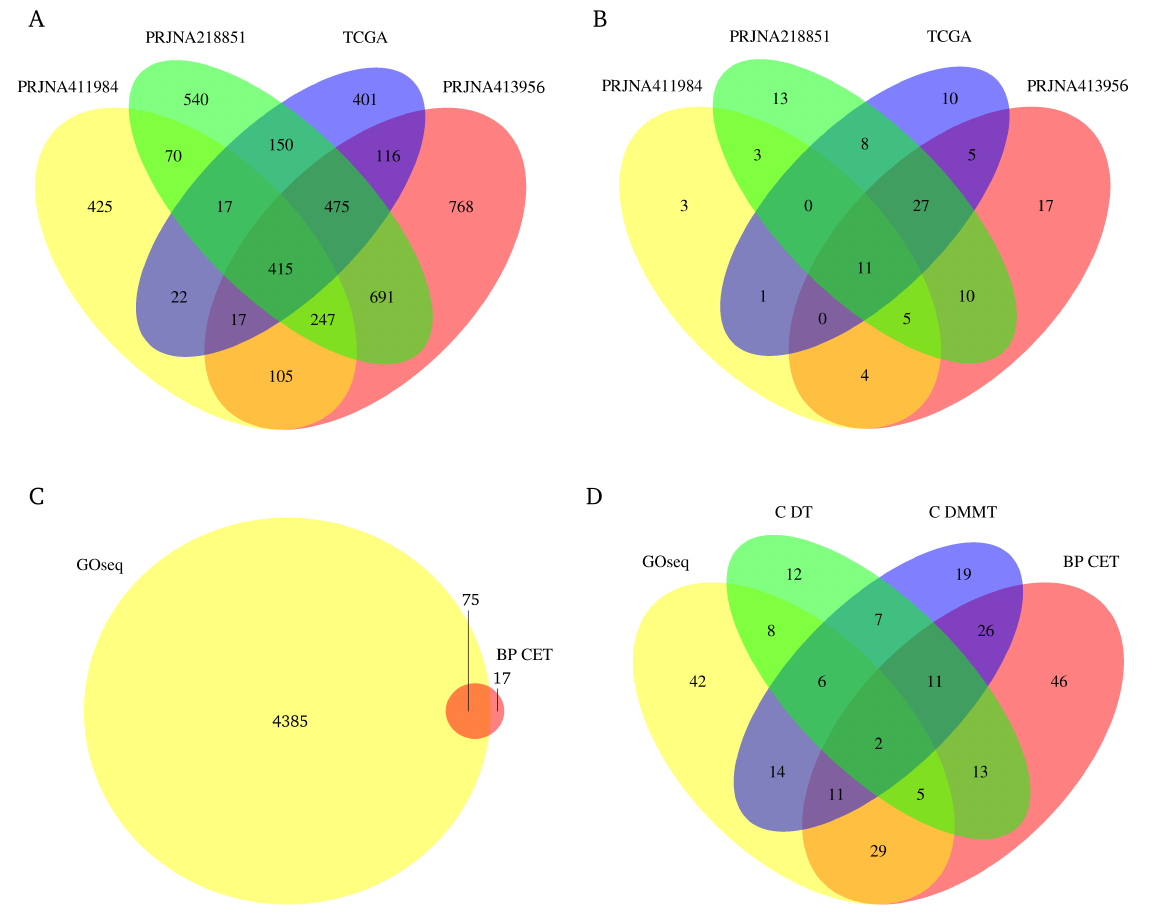
Figure 2. GO terms and KEGG pathways reported in common between datasets using GOseq and spatial tests. ( A ) GO terms reported by GOseq; ( B ) KEGG pathways reported by GOseq; ( C ) GO terms reported in common by GOseq and between-pair CET; ( D ) KEGG pathways reported in common by GOseq and between-pair CET, Complete DT, and Complete DMMT. If we use the KEGG pathways: 27, 79, 77, and 62 gene sets are reported in